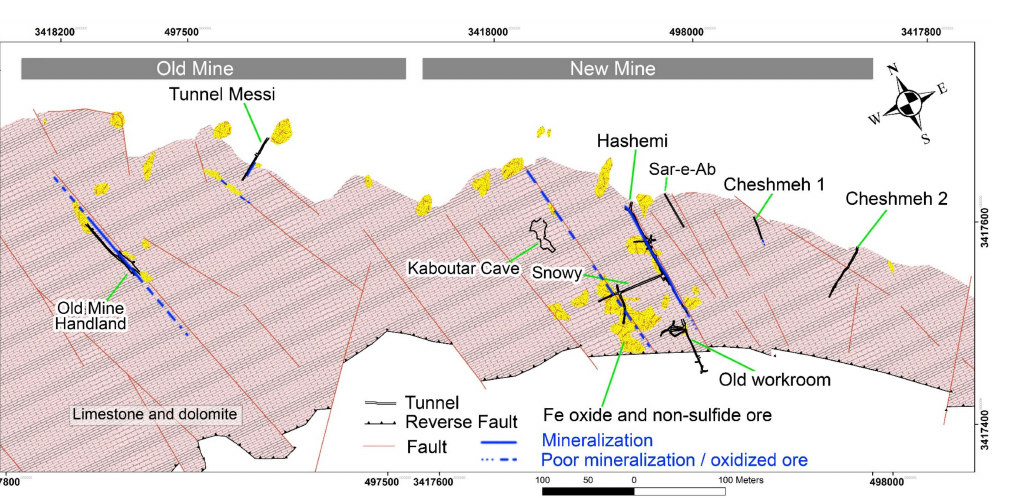
Figure 14. Simplified structural map of the host carbonate rocks and location of underground tunnels and adits, Ab-Bid